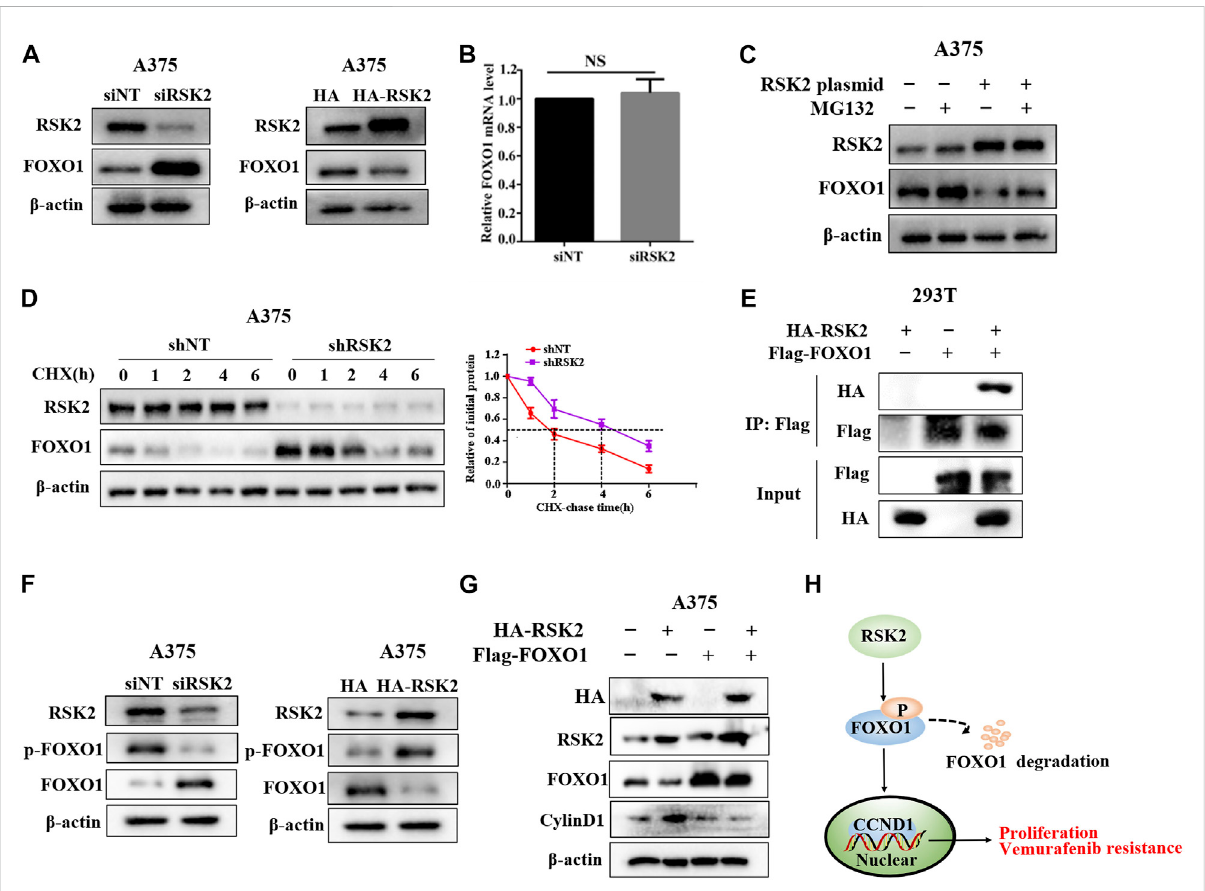
FIGURE 6 RSK2 upregulates cyclin D1 via promoting FOXO1 degradation. (A) Western blot was used to measure FOXO1 expression in A375 cells transfected with RSK2 siRNA or HA-RSK2 plasmid. (B) RT-qPCR was used to measure FOXO1 mRNA expression in A375 cells transfected with RSK2 siRNA. (C) The in fl uence of RSK2 on FOXO1 degradation was estimated in A375 cells under MG132 treatment. (D) The effect of RSK2 on FOXO1 protein stability was evaluated in A375 cells under CHX treatment for the indicated time. (E) HEK293T cells were co-transfected with Flag-FOXO1 and HA-RSK2 plasmid as indicated, immunoprecipitationwith anti-Flag antibody was performed. (F) Westernblot was used to measure p-FOXO1 (S319) and FOXO1 expression inA375 cells transfectedwith RSK2 siRNA or HA-RSK2 plasmid. (G) Western blot wasused to measure cyclin D1 expression in A375 cells co-transfected with Flag-FOXO1 and HA-RSK2 as indicated. (H) A schematic model of RSK2 – FOXO1 – cyclin D1 axis leading to melanoma proliferation and vemurafenib